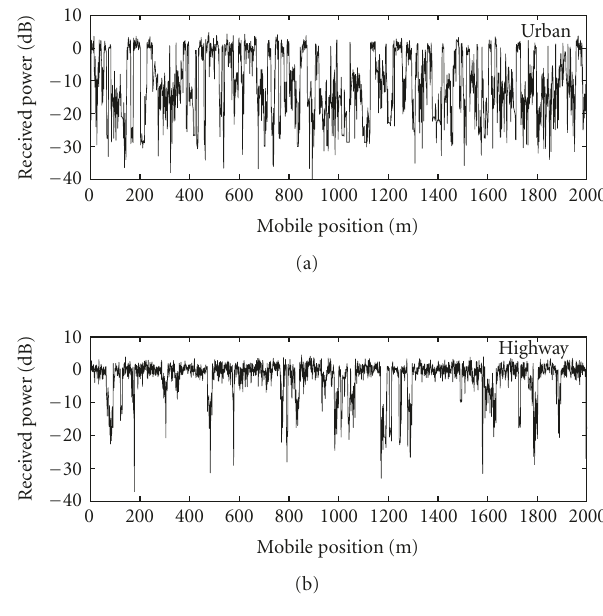
Figure 2: Example copolar time-series data of